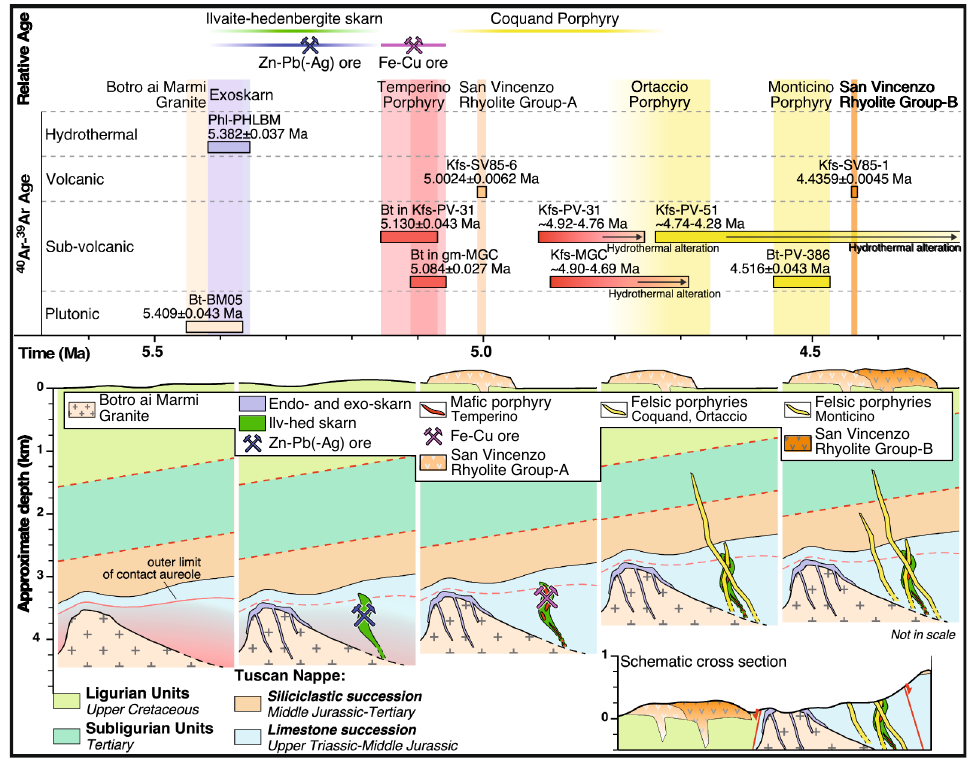
Figure 8. Sketch drawing summarizing the evolution of the Campiglia Marittima magmatic-hydrothermal system and consisting of intrusive, hydrothermal, subvolcanic and volcanic